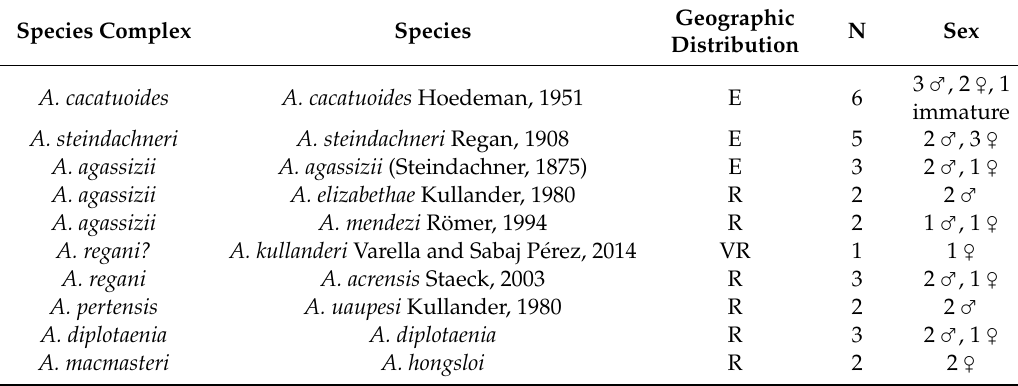
Table 2. Apistogramma species analyzed with the extent of geographic distributions. Species Complex Species